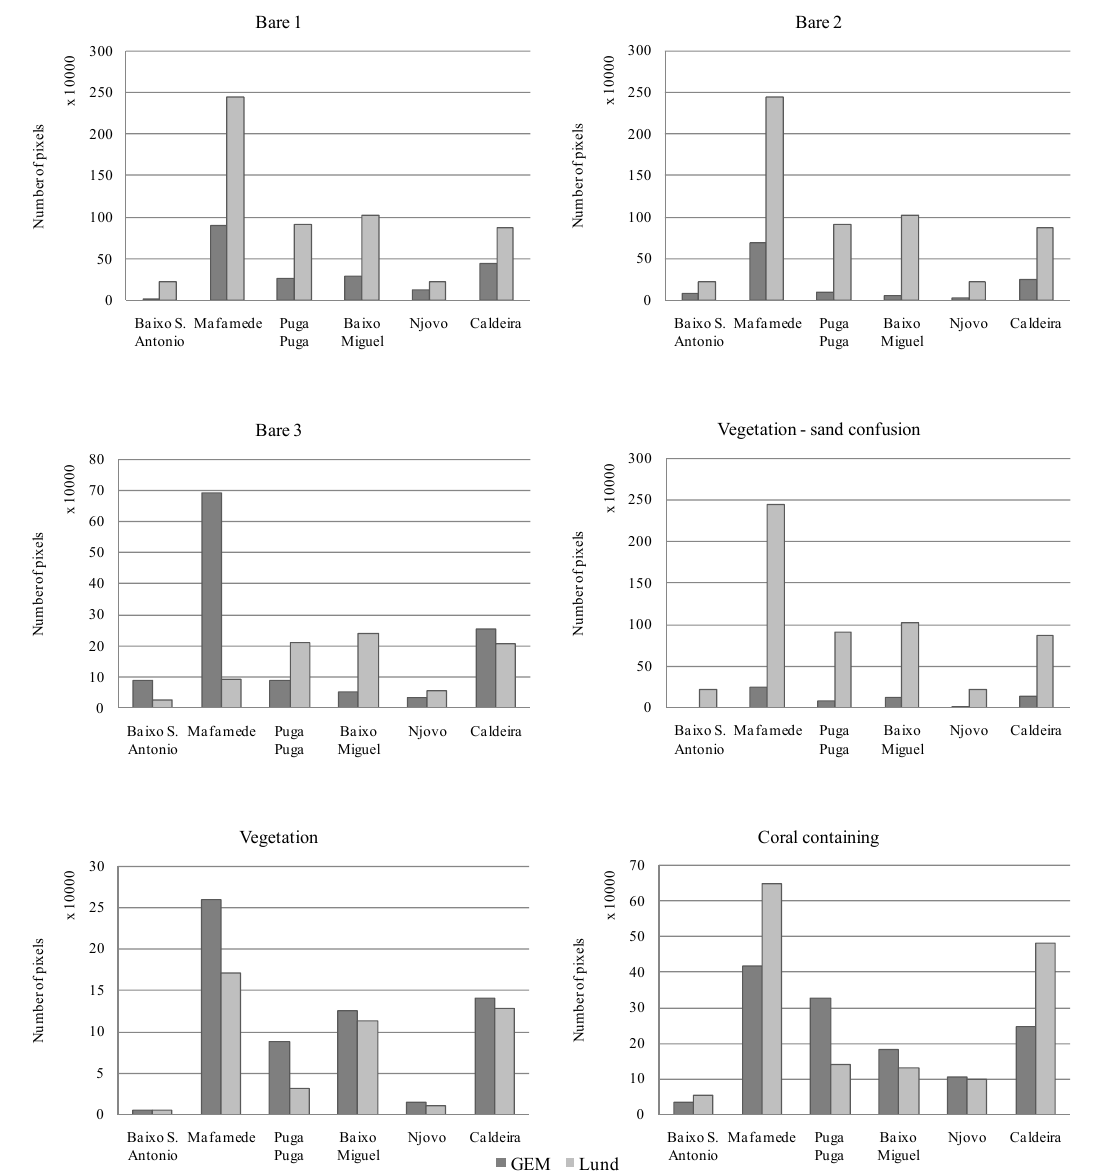
Figure 6. Paired class comparison across the different coral reef systems at the bottom cover and benthic habitat levels.